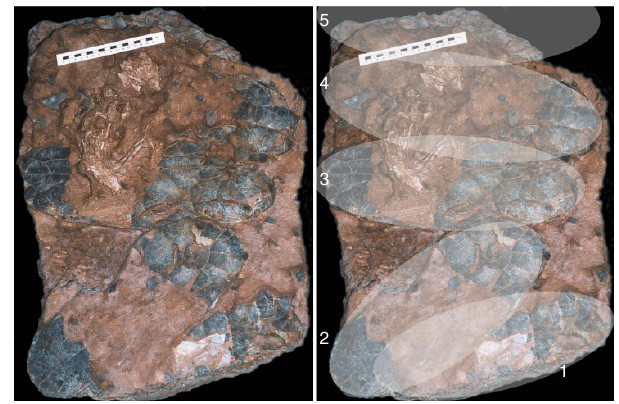
Figure 1 | Photograph of eggs and skeleton of Beibeilong sinensis (HGM 41HIII1219). Right image shows schematic overlay of approximate locations of individual eggs. Eggs 1 through 4 are in an upper layer just beneath the skeleton, whereas Egg 5 is in a lower layer of the block. Scale bar is in